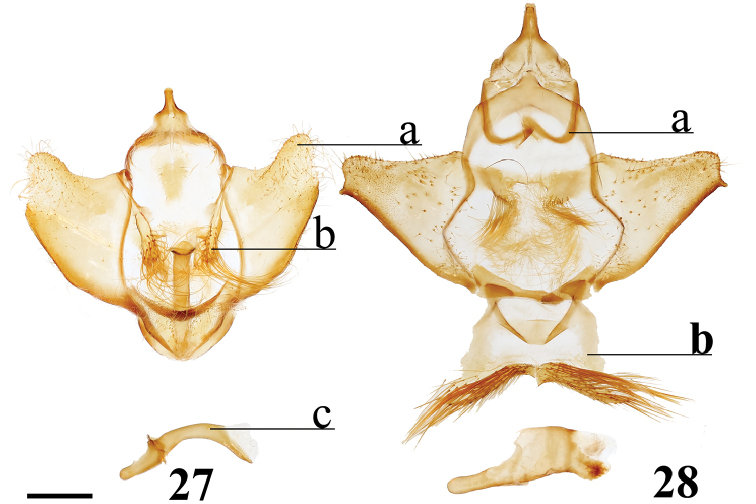
Ventral view of male genitalia of type species (except where noted) of genera belonging to Druenticinae: Luramini. Phallus/juxtal complex is figured below the genitalia in the lateral view. Figures are reused with permission from St Laurent (2016), ZooKeys. 27Luramaquindiuna, St Laurent diss.: 2-14-16:5, not the type species of Lurama (USNM) 28Ulmararotunda, St Laurent diss.: 4-5-16:3 (MNHU). Scale bar: 1 mm.